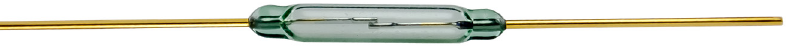
Figure 1. External view of a reed switch (RS) prototype model studied in this work. Its overall dimension is 44.7 mm, the bulb ʹ s length and diameter are 14.2 mm and 2.3 mm, respectively.